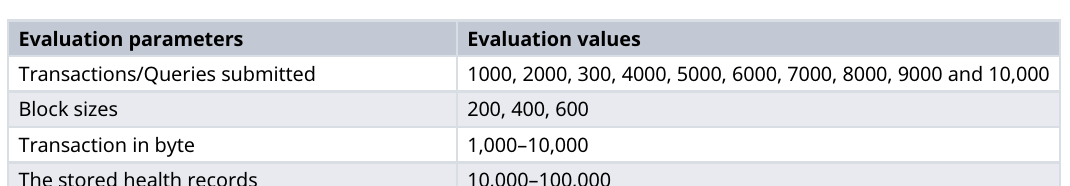
Table 1. Experiment